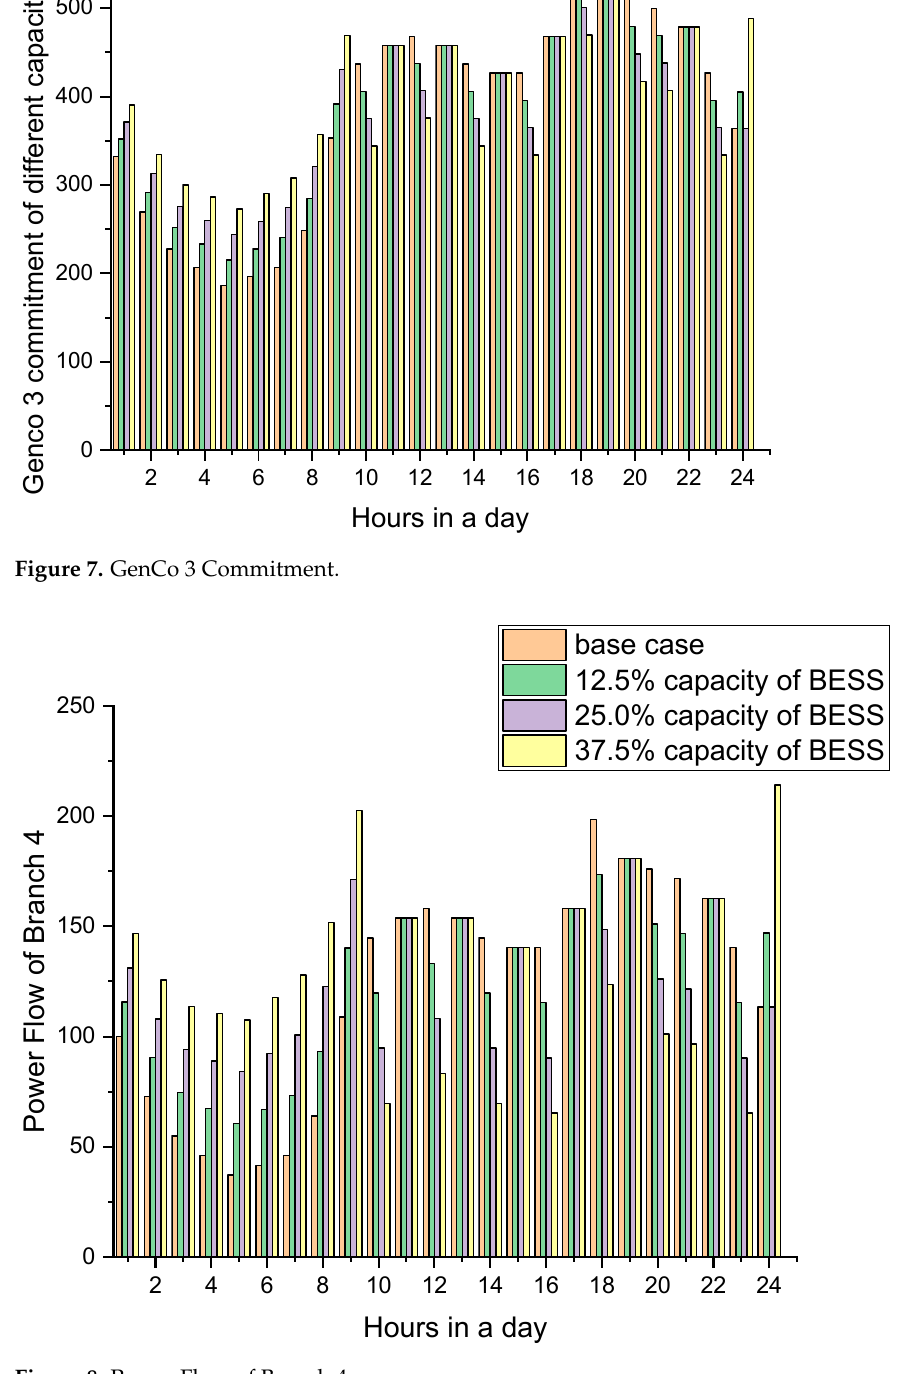
Figure 8. Power Flow of Branch 4.